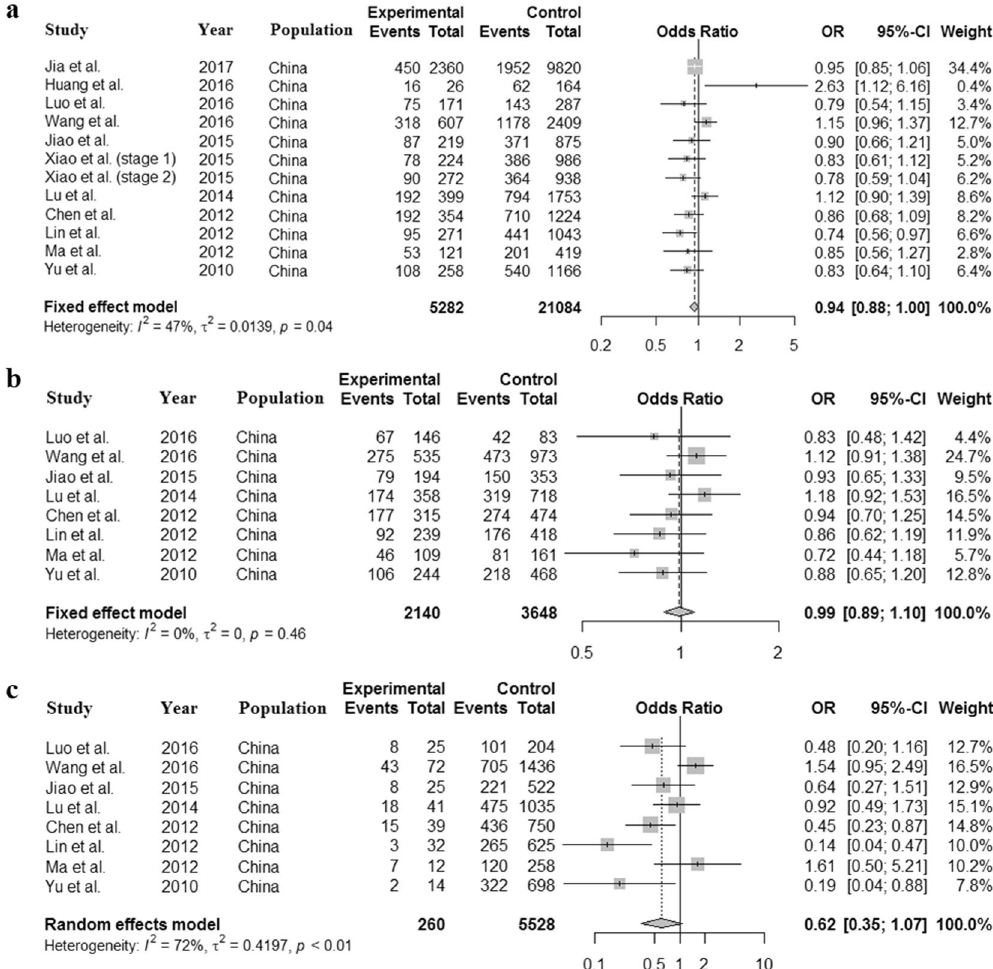
Figure 4. Forest plot for the meta-analysis of rs11136000 polymorphism in Chinese population. The association between rs11136000 polymorphism and AD was not significant in the allele ( a ), dominant ( b ) and recessive model ( c